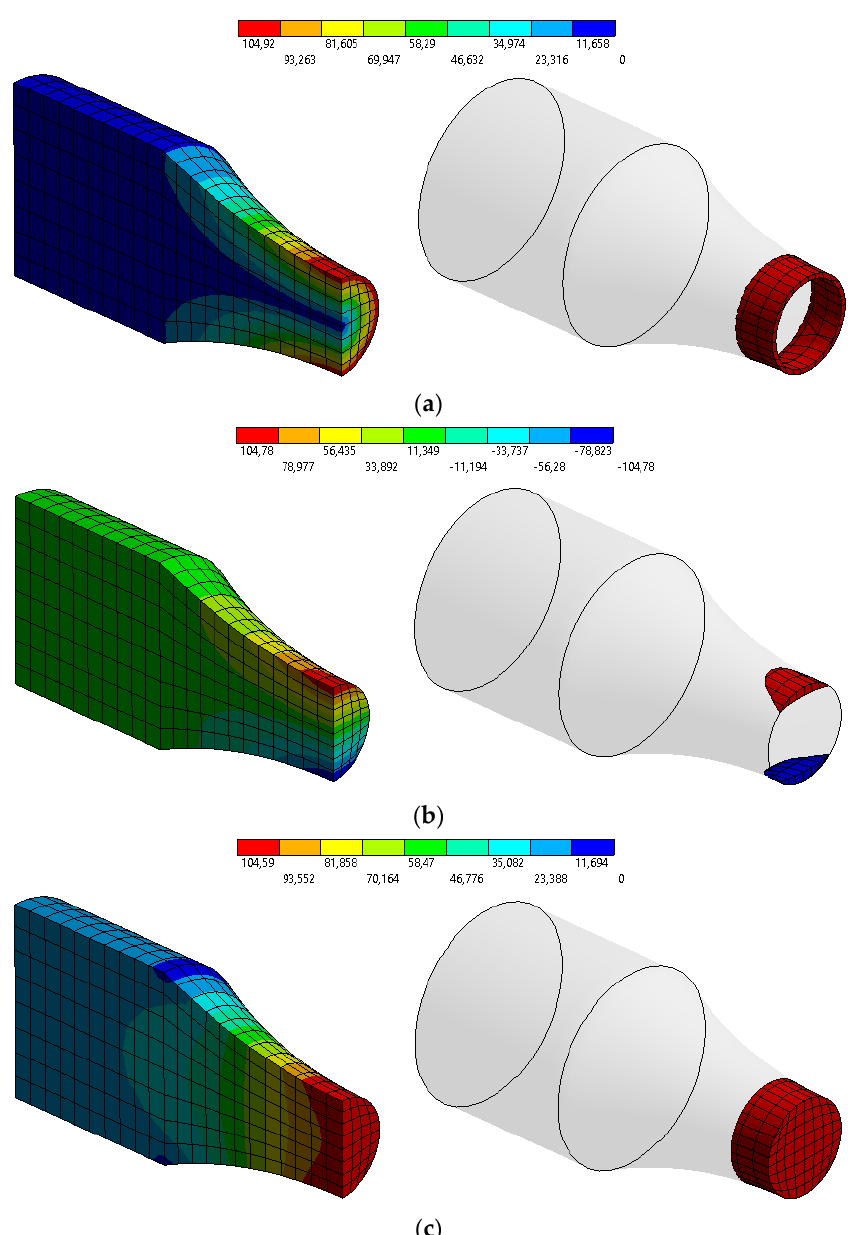
Figure 6. Normal stress distribution map (nominal stress 100 MPa) for round specimen under: ( a ) rotary bending (highly-stressed volume), ( b ) pure bending (highly-stressed volume static), ( c ) axial loading. Table 5. Values of the 3-parameters Weibull models for AW 6063 T6.